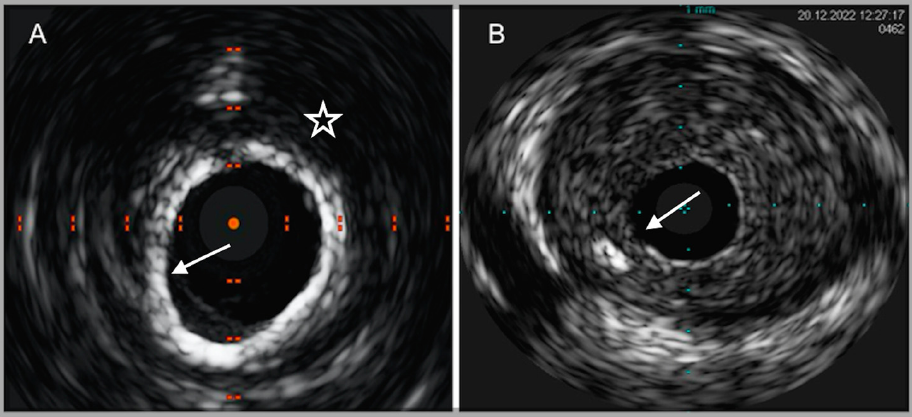
Figure 1. IVUS images of coronary plaque phenotype. ( A ) Example of a calcific plaque, depicted as a bright leading circumferential structure (( A ), white arrow) with deeper shadowing (( A ), white star). ( B ) Example of predominantly fibro-fatty plaque, depicted as a structure showing less echogenicity than the surrounding adventitia with a spotty calcification (( B ), white arrow), characterized by a focal hyperechoic signal and deeper shadowing.